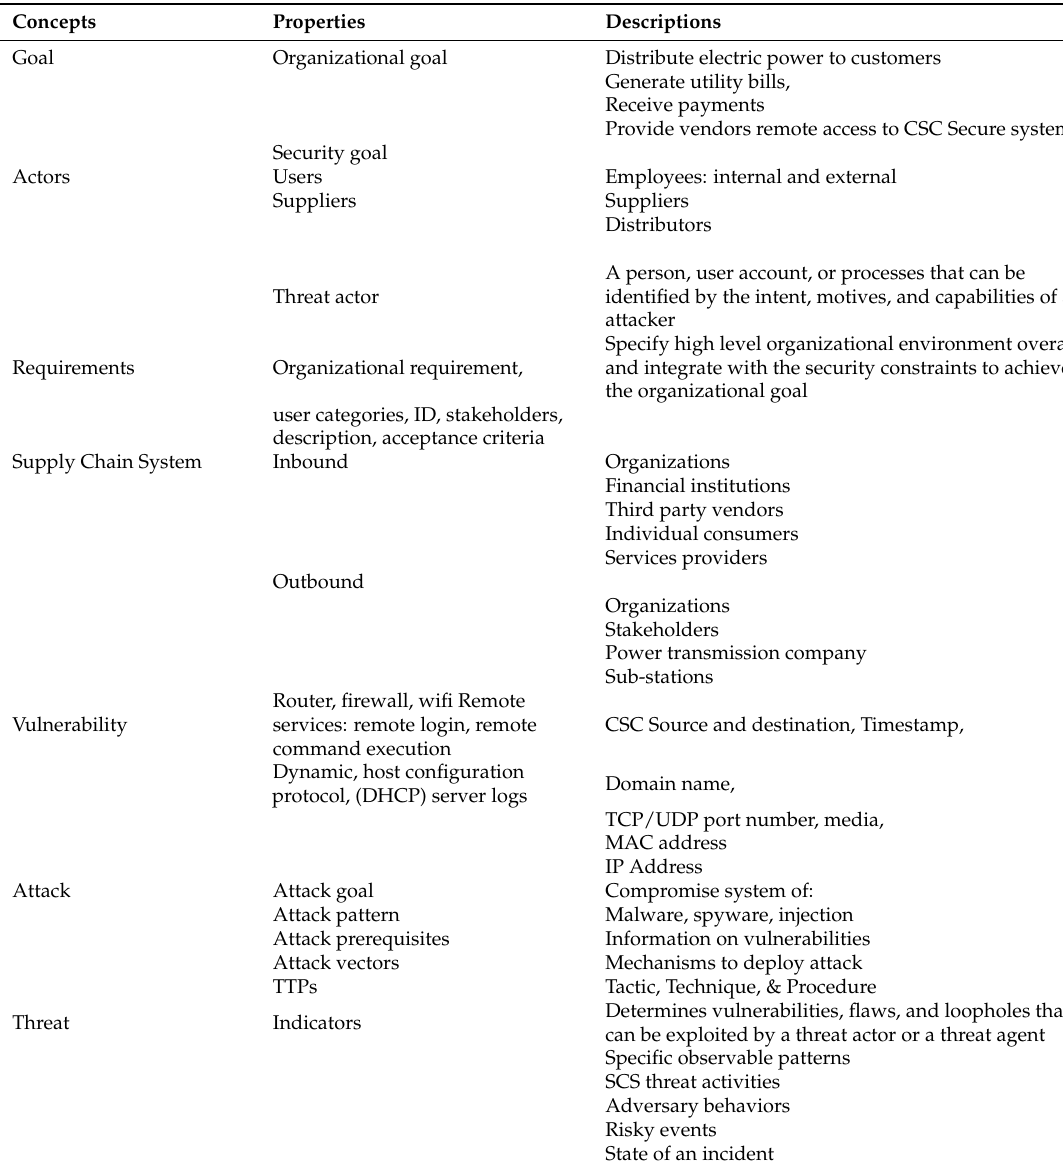
Table 2. Mapping the case study with the meta-model